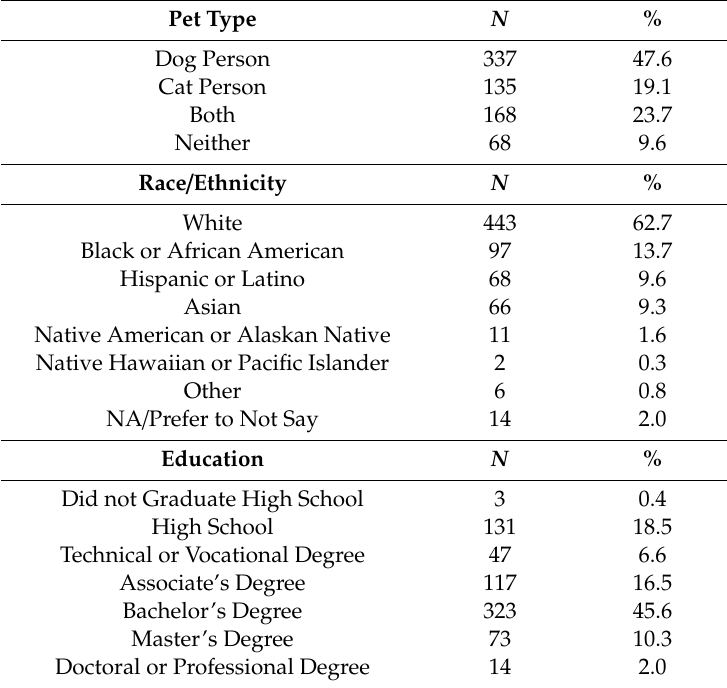
Table 1. Demographics of participants: Survey / Male 1.